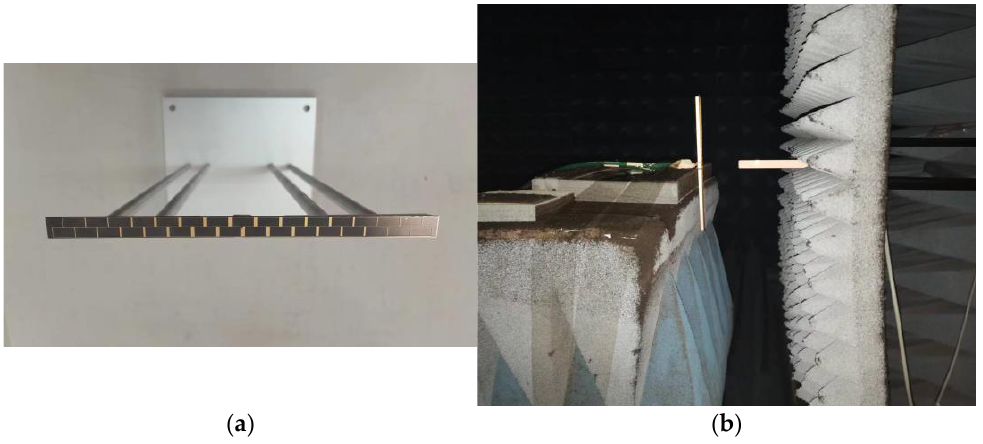
Figure 13. ( a ) Photograph of the fabricated grid antenna; ( b ) measurement of grid antenna in the anechoic